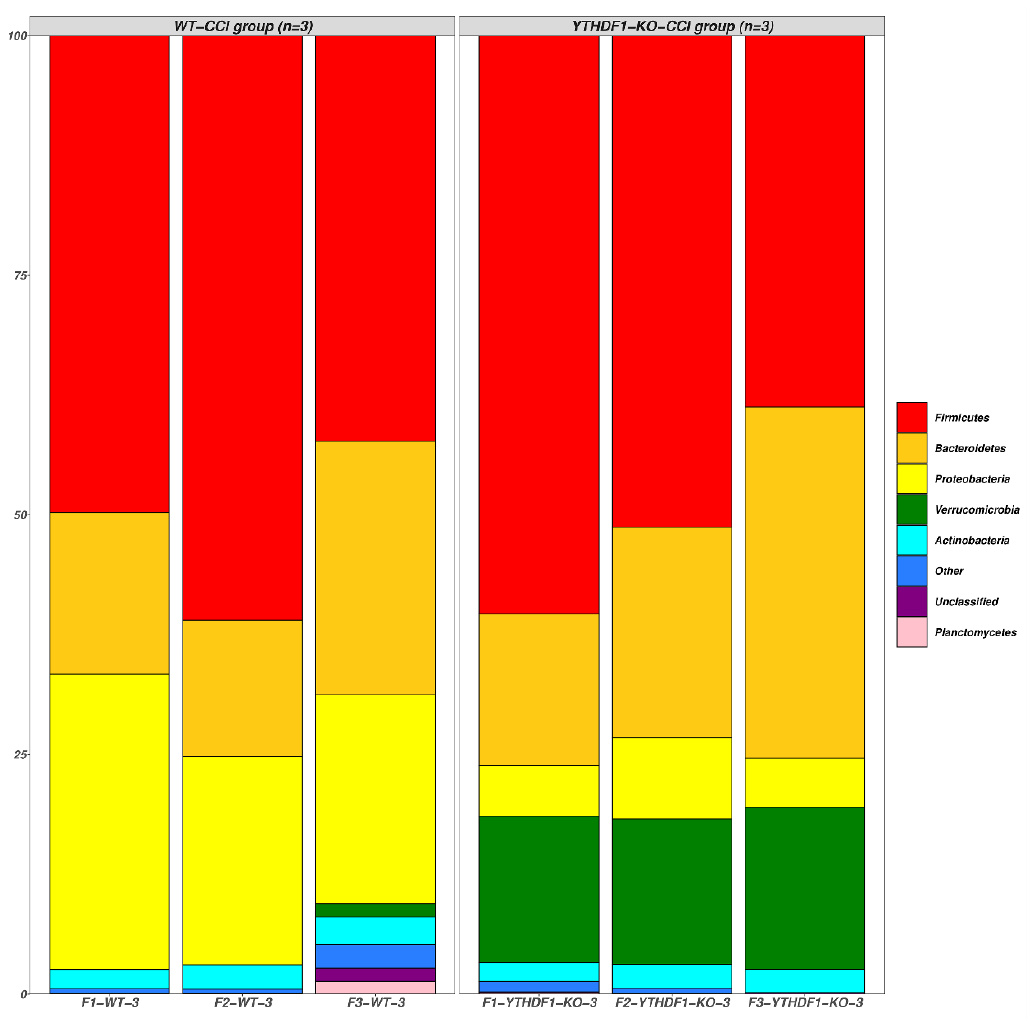
Figure 5. The bar plots show the relative phylum abundance of fungal microbiomes in faecal samples of WT mice and YTHDF1-knockout mice at 3 days post-CCI (YTHDF1-KO = YTHDF1-knockout). They were detected by high throughput sequencing on Internal transcribed spacer 2 (ITS2) of ribosomal DNA and analysed using the QIIME2 pipeline.